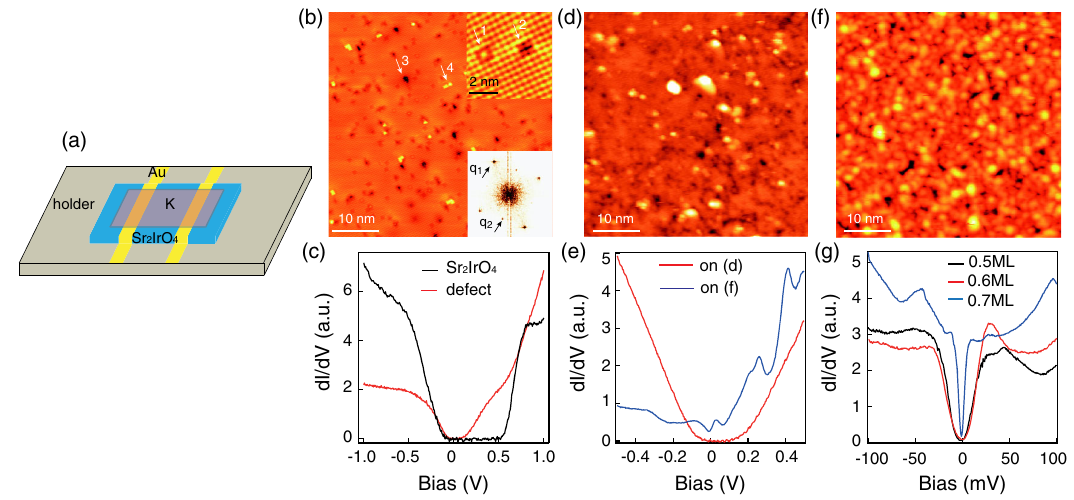
FIG. 1. Surface topography and d I =d V spectrum of Sr 2 IrO 4 with and without K coverage. (a) Sketch of the sample configuration. (b) Typical topographic image on the SrO-terminated surface of pristine Sr 2 IrO 4 , measured at 77 K. The top and bottom insets represent the atomically resolved image and the FT of data in panel (b), respectively. Four different kinds of defects are indicated by arrows. (c) Spatially averaged d I =d V spectrum on the SrO-terminated surface. An insulating energy gap as large as 700 meV is observed on the defect-free region, while a reduced gap is observed on defects 3. (d) Typical topographic image of the SrO-terminated surface adjacent to Au contacts (measured at 20 K), in which a few Au clusters are observed as the white spots. (e) Spatially averaged d I =d V spectra measured on panels (d) and (f), showing a reduced insulating gap and a metallic state, respectively. (f) Typical topographic image after depositing 0.6 ML K atoms on the SrO-terminated surface that is adjacent to the Au contacts (measured at 20 K). (g) Representative d I =d V spectra on K-doped Sr 2 IrO 4 with various K coverages (10 K for 0.5 ML, 20 K for 0.6 ML, 4.5 K for 0.7 ML), showing V-shaped